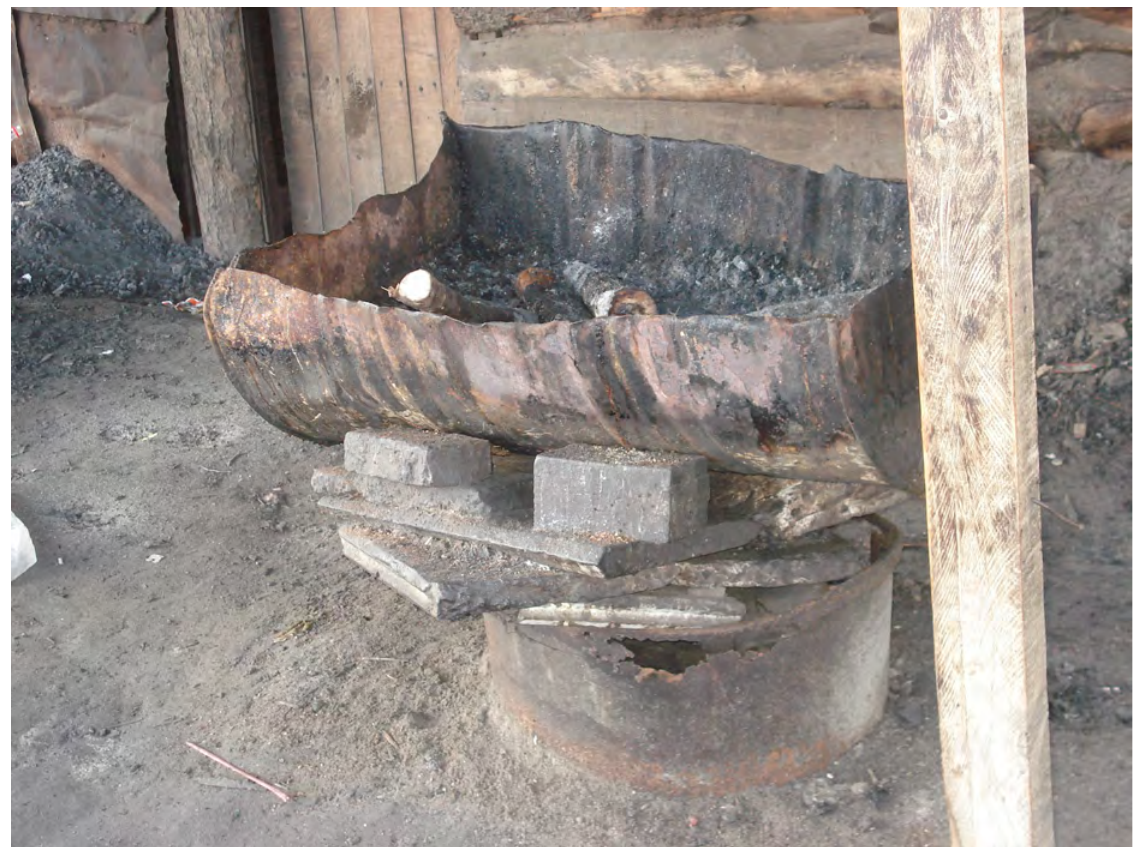
Figure 2: The base section of the type of wood braai currently being used by meat traders in